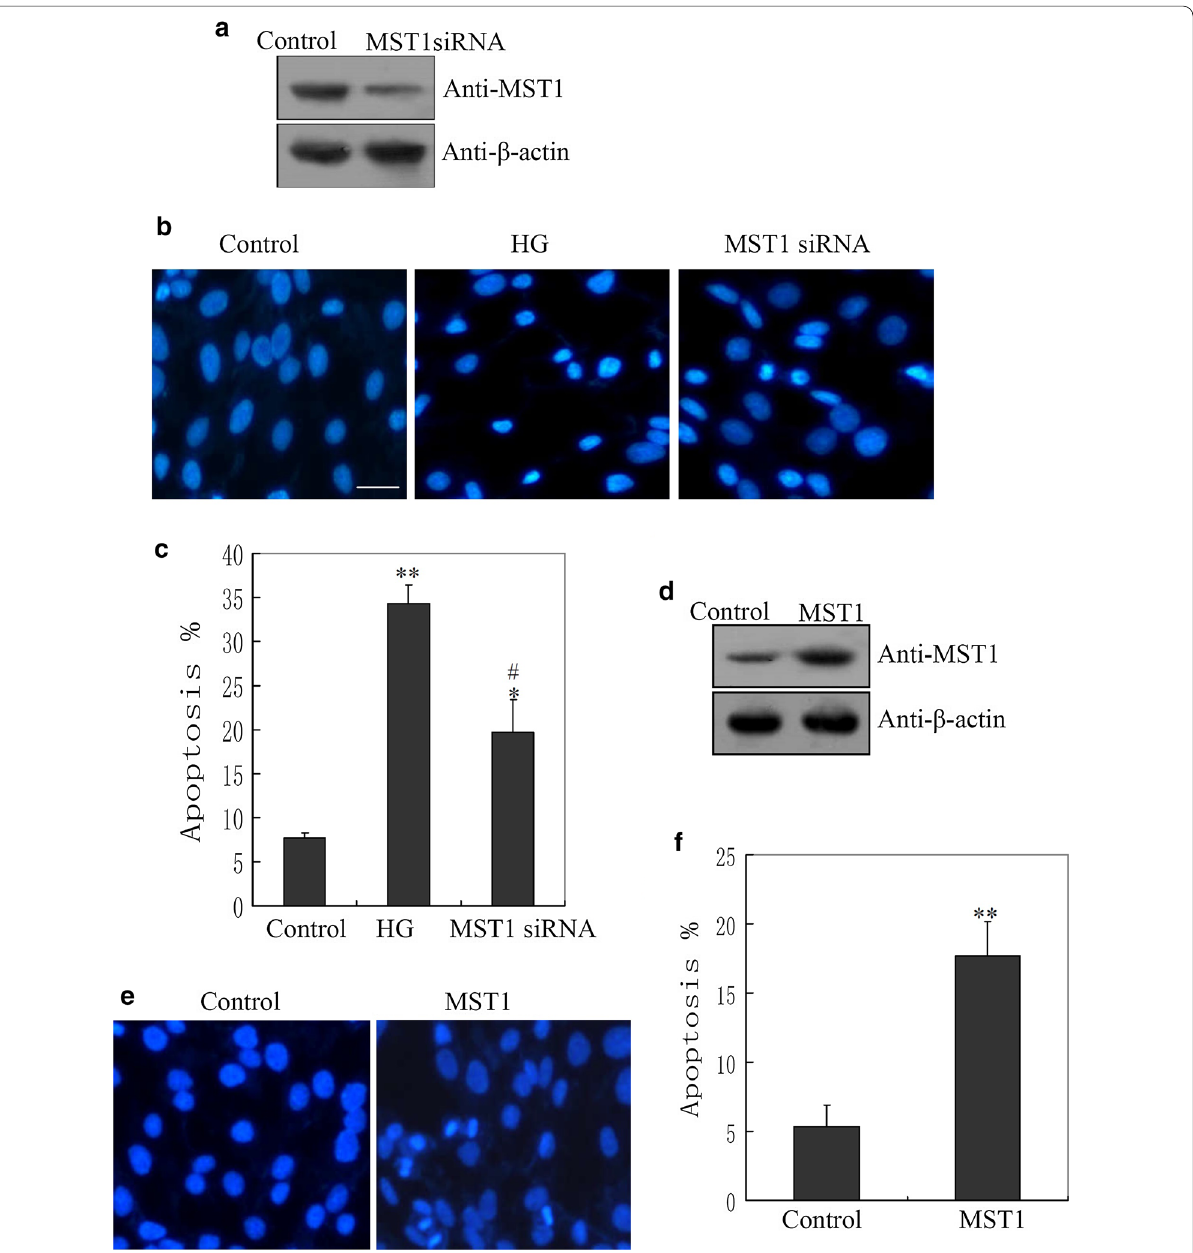
Fig. 2 Effects of mammalian sterile 20-like kinase 1 (MST1) on high glucose (HG)-induced cardiomyocyte apoptosis. a Western blotting confirmation of MST1 knockdown by an MST1-specific or control small interfering RNA. b Hoechst 33342 staining assay showing restrained HG-induced cell apoptosis under knockdown of MST1. c Apoptosis rates were calculated based on 100 cells and analyzed after HG treatment; ≥ *p < 0.05 and **p < 0.01 versus the untreated group; # p < 0.05 and ## p < 0.01 versus the HG-treated group. d Western blotting confirmation of ectopic overexpression of MST1 after transfection of H9C2 cells. e Hoechst 33342 stain apoptosis assay showing the effect of MST1 overexpression on apoptosis in H9C2 cells; (F) Apoptosis rates were calculated based on 100 cells and analyzed after MST1 transfection; *p < 0.05 and **p < 0.01 ≥ versus the non-transfected